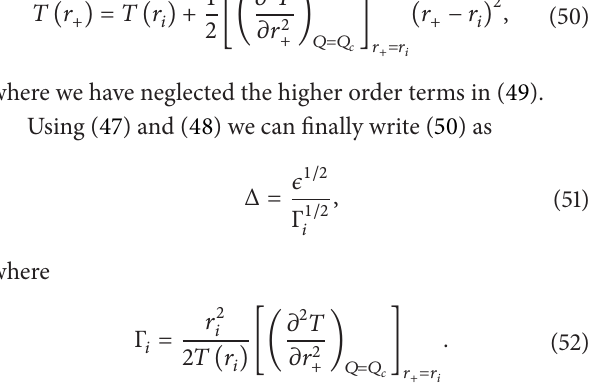
Figure 11: Plot of free energy ( F ) against horizon radius ( 𝑟 + ), for 𝛼 󸀠 = 0.50 , 𝑄 = 0.50 , and 𝑏 = 10 .